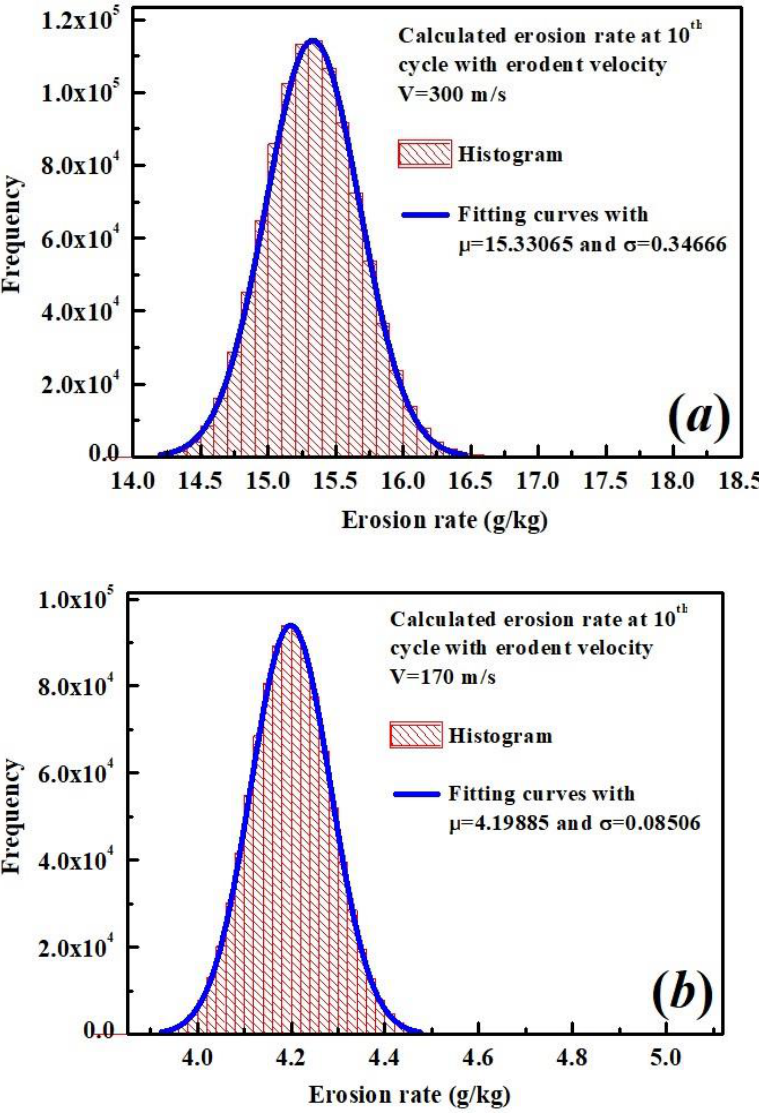
Figure 13. The calculated erosion rate at 10th cycle with impact velocity ( a ) V = 300m/s ( b ) V = 170m/s.